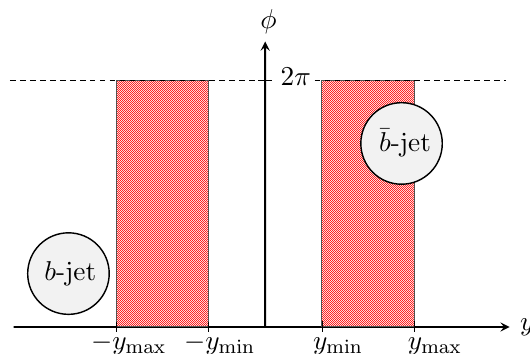
Figure 1 . Sketch of the veto region as de(cid:12)ned by ATLAS in [18]. The gap, in which additional radiation is vetoed, is represented by the shaded red area with rapidity y min < j y j < y max . Radiation inside the b -tagged jets is not vetoed. For y min = 0, this setup reduces to the usual central jet